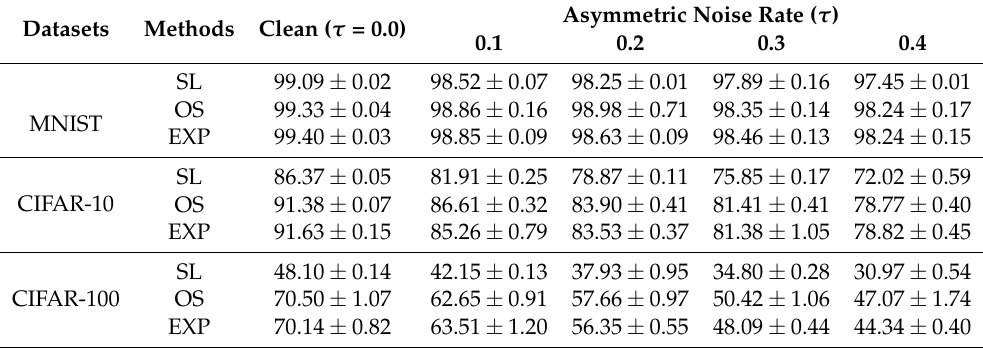
Table 4. Test accuracy (%) of different methods on benchmark datasets with clean or asymmetric [ 0.1,0.4 ] ). The results (mean label noise ( τ std) are reported over three random runs. SL refers to a ∈ ± training schedule with a small learning rate that remains constant throughout the training process. OS (one-step) denotes a training schedule where the learning rate starts at a high value and then drops to a smaller value after a specified number of training steps. Exp refers to a training schedule where the learning rate decreases exponentially as the training progresses.